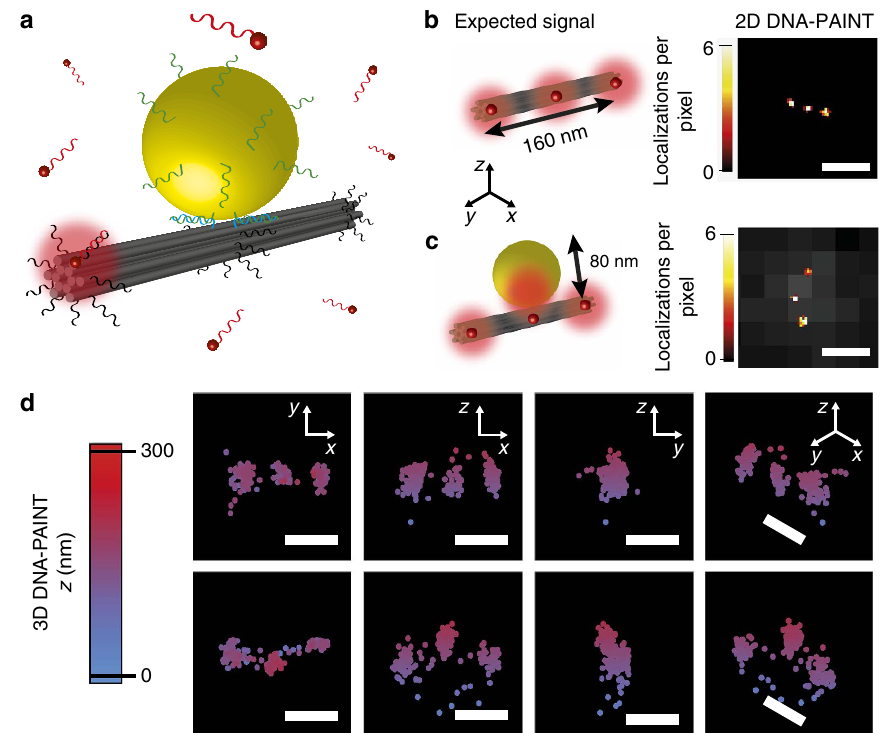
Figure 2 | Observation of the single-molecule mirage. ( a ) Working principle of the assay using DNA origami to observe the shift in molecular localization produced by plasmonic coupling. The 12-helix bundle (12HB) DNA origami structure provides sites for the dynamic binding of single fluorophores at three regions (at each end and at the centre) separated by 80nm. In addition, at the centre of the 12HB there are docking sites for the incorporation of a DNA-modified AuNP in close contact (zipper configuration) 37 , on top of the 12HB. The DNA origami structures are fixed on the substrate with random orientations. ( b , c ) Schematic depicting the expected emission spots next to a representative 2D DNA-PAINT image of a 12HB without ( b ) and with an 80nm AuNP attached ( c ). The presence of the AuNP is evidenced by its scattering signal (overlaid in grey scale). ( d ) 3D DNA-PAINT imaging of a 12HB without (top) and with (bottom) an 80nm AuNP attached. Scale bars: ( b , c ) 200nm. ( d )